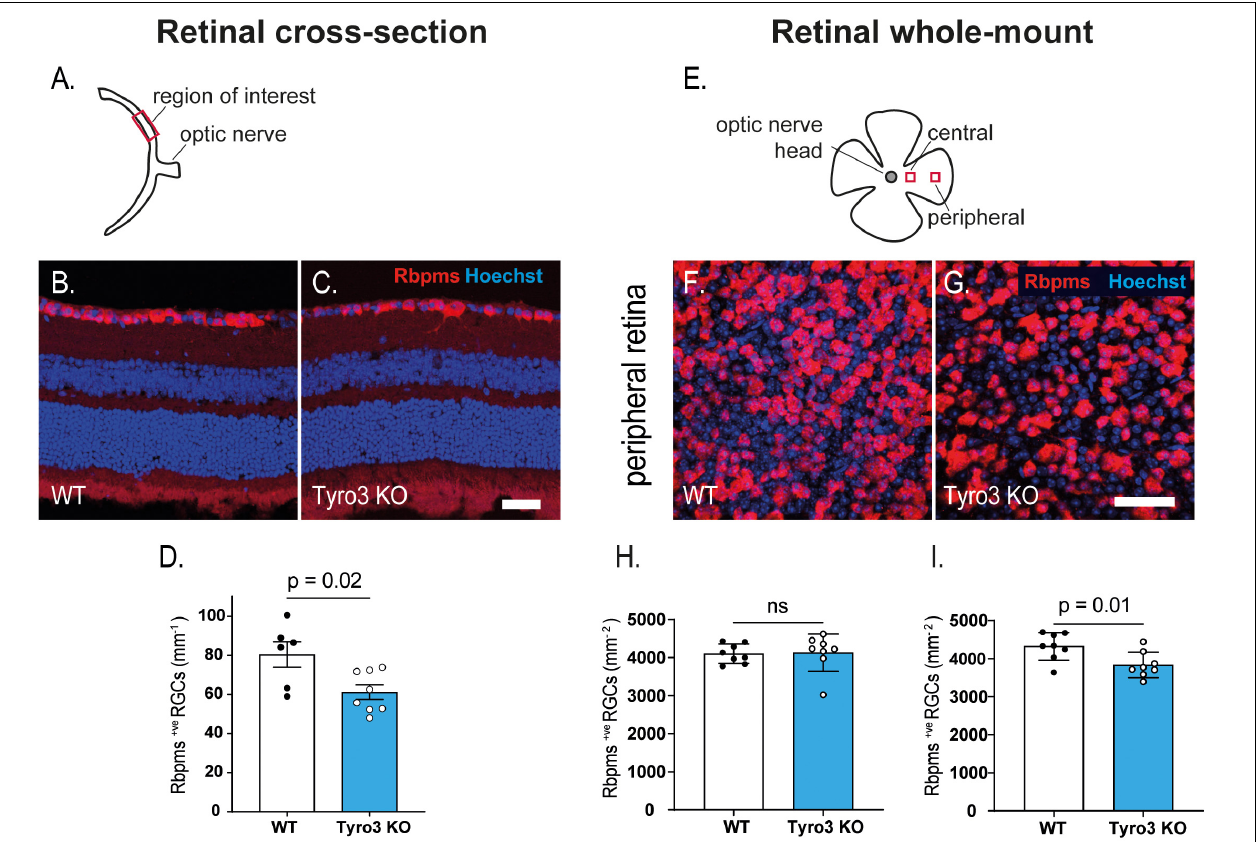
FIGURE 3 | Dysregulation of retinal function is accompanied by a loss of RGCs. The density of retinal ganglion cells was determined in retinal cross-sections and in retinal flat-mounts. (A) Schematic of retinal cross-section identifying the region of interest. Representative images of retinal cross-sections derived from WT (B) and Tyro3 KO (C) mice stained for Rbpms (red) and Hoechst (blue) are shown. Significantly fewer Rbpms + ve RGCs were observed in the Tyro3 KO ( n = 8) mice compared with WT mice ( n = 6) ( D ; p = 0.02). (E) Schematic representation of flat-mounted retinas identifying the two regions of interest. Representative images of flat-mounted sections derived from the peripheral region of WT (F) , and Tyro3 KO (G) mice stained for Rbpms (red) and Hoechst (blue) are shown. No difference was observed in Rbpms + ve RGCs in the central retina between Tyro3 KO and WT mice (H) . However, significantly fewer Rbpms + ve RGCs were found in the peripheral retinas derived from Tyro3 KO mice compared with WT mice ( I ; p = 0.01). Results are presented as mean ± SEM; p -value of mean differences were calculated using a two tailed Student’s t -test. Scale bars represent 50 µ